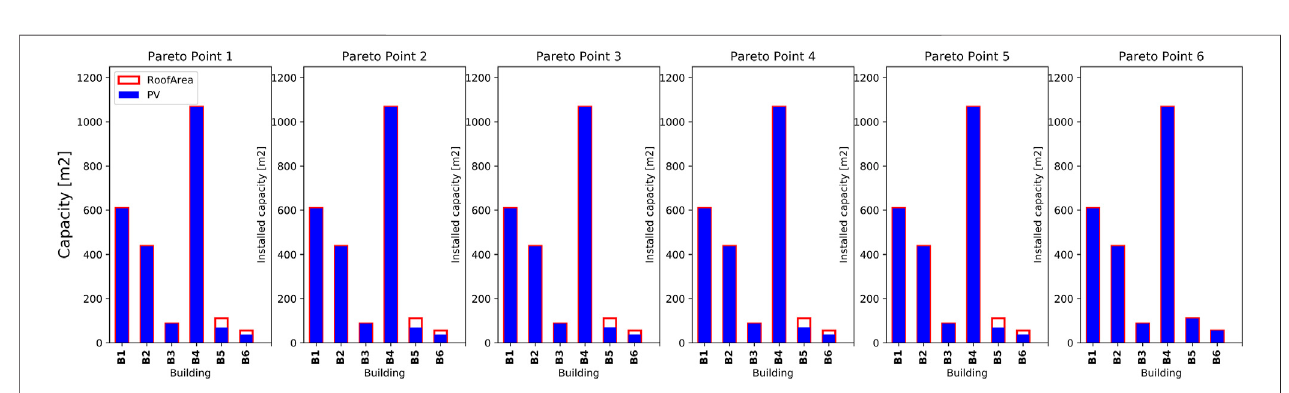
FIGURE 11 | installed PV capacities on each building for all Pareto optimal